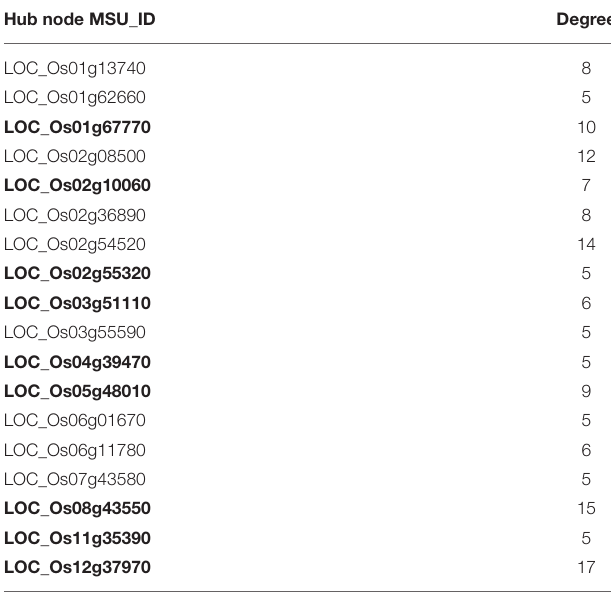
TABLE 1 | Hub OsMYB genes that were significantly enriched with abiotic stress and hormone related Gene Ontology (biological process). Hub node